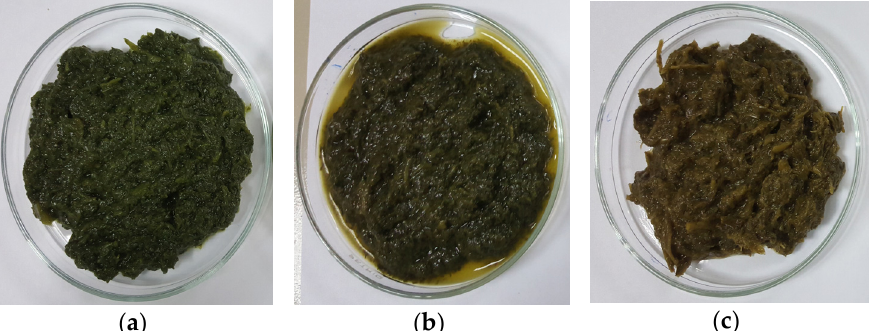
Figure 4. Absorbance spectra of acetone extracts of fresh and metal-stabilised amaranth purees (Cu-amaranth puree: 120 mg/L of CuSO 4 at 80 °C for 15 min, Zn-amaranth puree: 1500 mg/L of ZnCl 2 at 90 °C for 15 min.